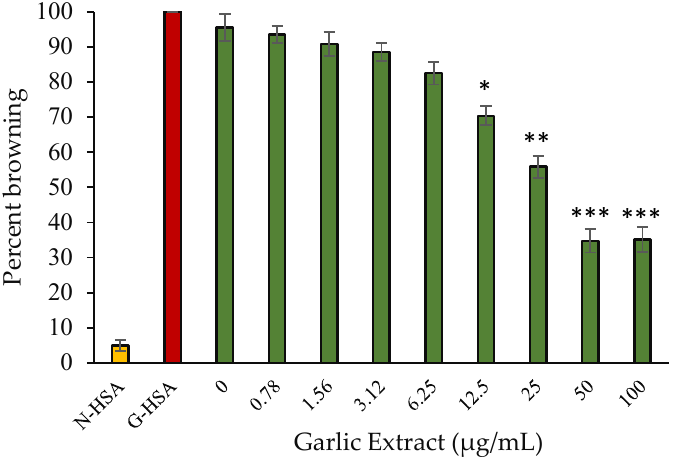
Figure 4. Percentage browning vs. concentration of garlic extract. Native HSA (N-HSA) and glycated HSA (G-HSA) were incubated for 10 weeks under similar conditions and are considered as negative and positive controls, respectively. G-HSA was co-incubated with garlic extract at various concentrations (0–100 µ g/mL) of garlic extract (green). The results are presented as means ± SEM ( n = 3). All the percentage browning inhibition results (0.78–100 µ g/mL garlic extract) were compared with G-HSA sample. Comparison between two groups was performed based on t test, and significance was defined as * p < 0.05, ** p < 0.01, *** p < 0.001.